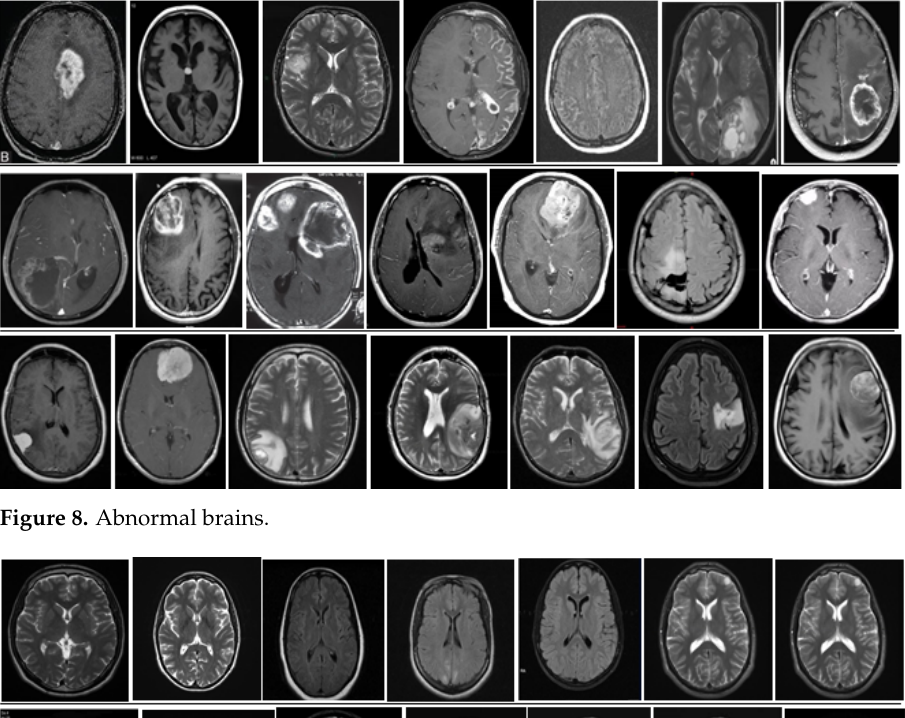
Figure 8. Abnormal brains.